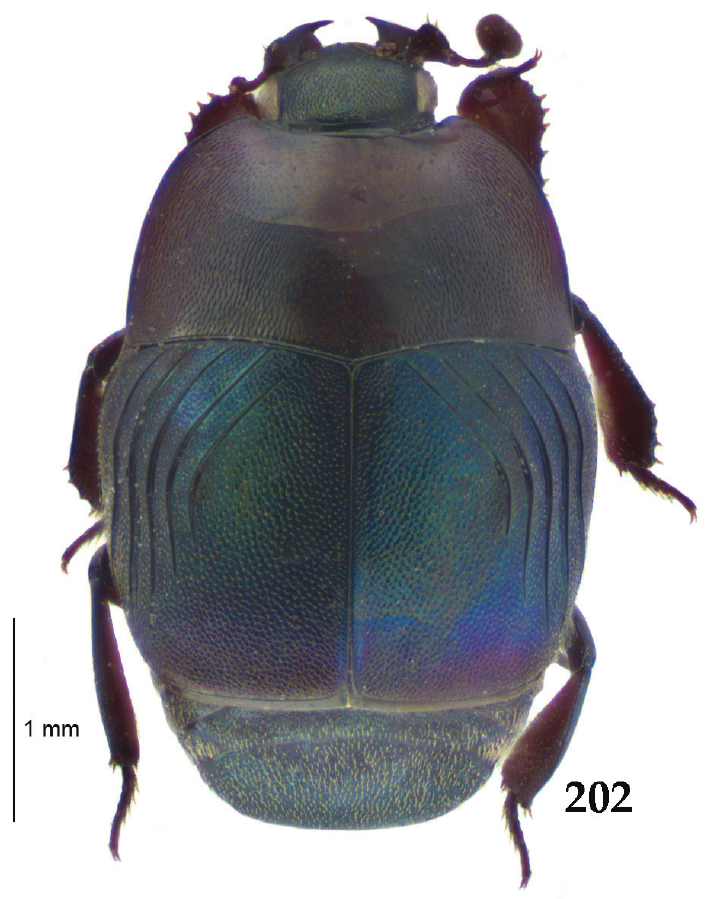
Figure 202. Iridoprinus myrmecophilus sp. n., habitus, dorsal view. Clypeus (Fig. 203) dorsally flattened, rounded laterally, with fine elongated punc- tures, separated by several times their diameter; supraorbital stria well developed, fron- tal stria carinate, prolonged onto clypeus; frontal disc (Fig. 203) densely punctuate, punctures deep, separated by about their diameter becoming elongate anteriorly, inter- spaces imbricate; eyes convex, well visible from above. Pronotal sides (Fig. 202) feebly convergent anteriorly, apical angles obtuse, mar- ginal pronotal stria present, laterally carinate, absent behind head; disc behind head with almost glabrous triangularly shaped ‘mirror’ (=polished area) with only scattered microscopic punctures, rest of pronotal disc coriarious-punctate, punctures becoming denser and coarser laterally, forming confluent elongate wrinkles; pronotal hypomeron glabrous; scutellum small, well